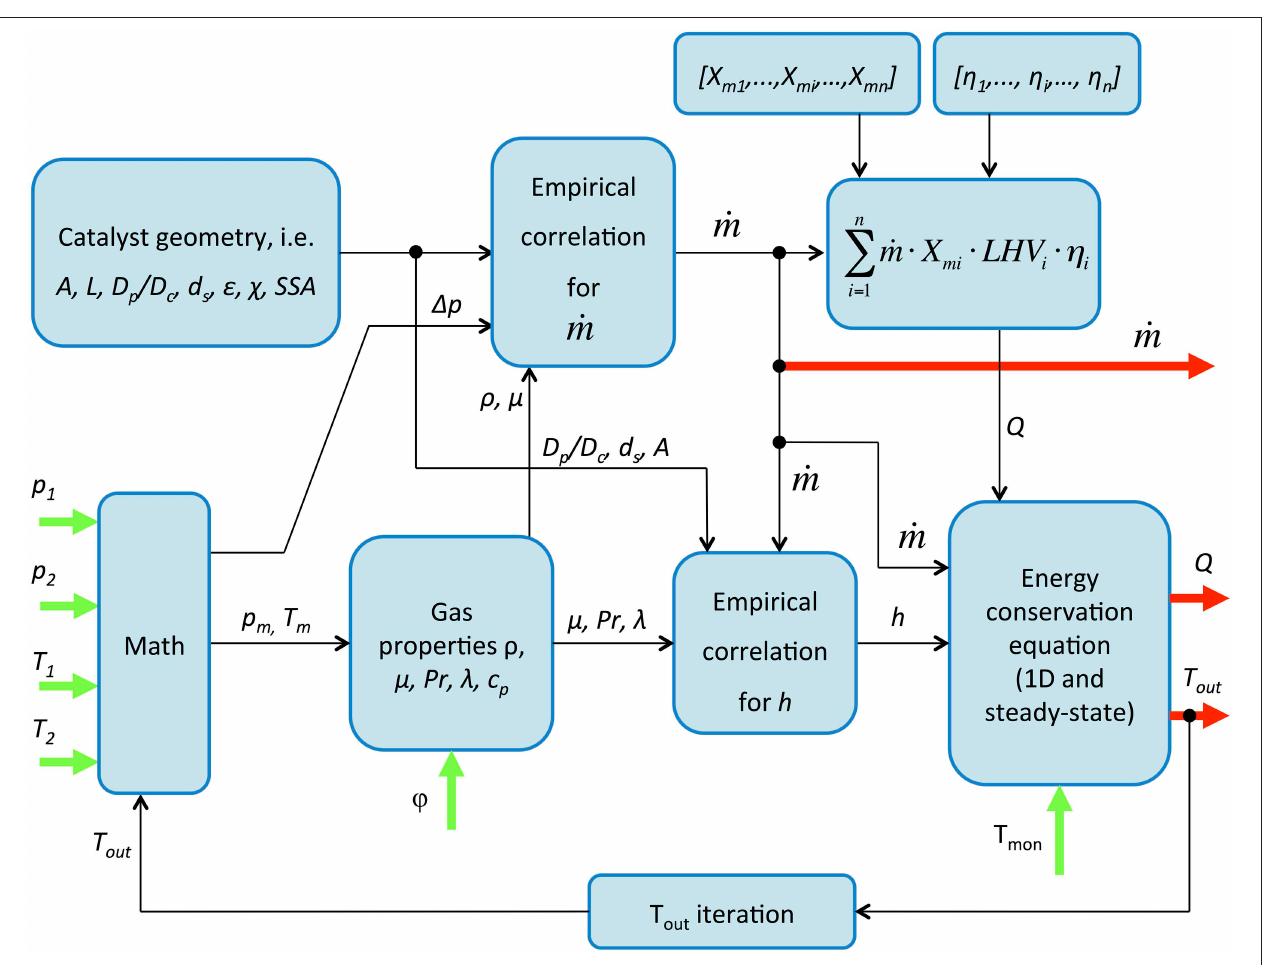
FIGURE 4 | Structure of the “gas model” module (input and output variables are in green and red,